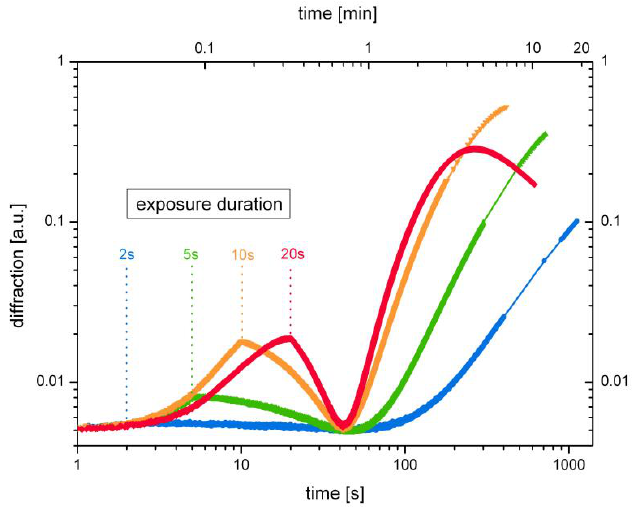
Figure 4. Grating growth curves in the undoped SU-8 on a double logarithmic scale for various exposure durations.